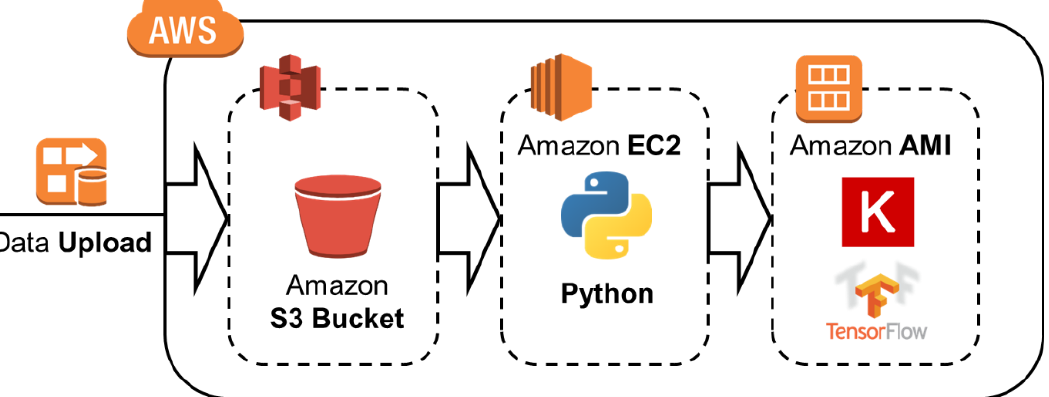
Figure 2. The system architecture implemented in the current study.